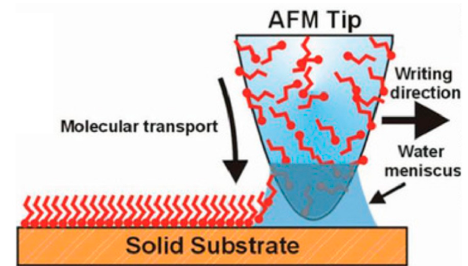
Figure 8. Scheme of the mechanism for molecular ink deposition by dip pen nanolithography (DPN). The atomic force microscopy (AFM) tip loaded with the molecules to pattern is brought into contact with the solid substrate to induce the molecular transport process through the water meniscus in between the tip and the receiving surface. As sketched, molecules containing chemical moieties that strongly interact with the solid surface can be chosen, thereby inducing an ordered orientation of the chemical structures at the interface (e.g., self-assembled monolayers, SAM). Reproduced with permission from Reference [68] Copyright © 2019 Table 1. Main features of the printing methods relevant for ZnO-based inks printing reported in this review.